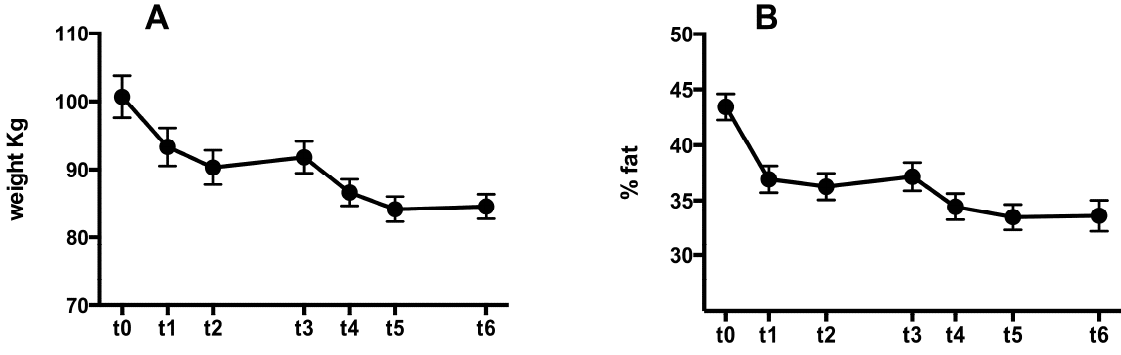
Error bars indicate standard error of the mean.